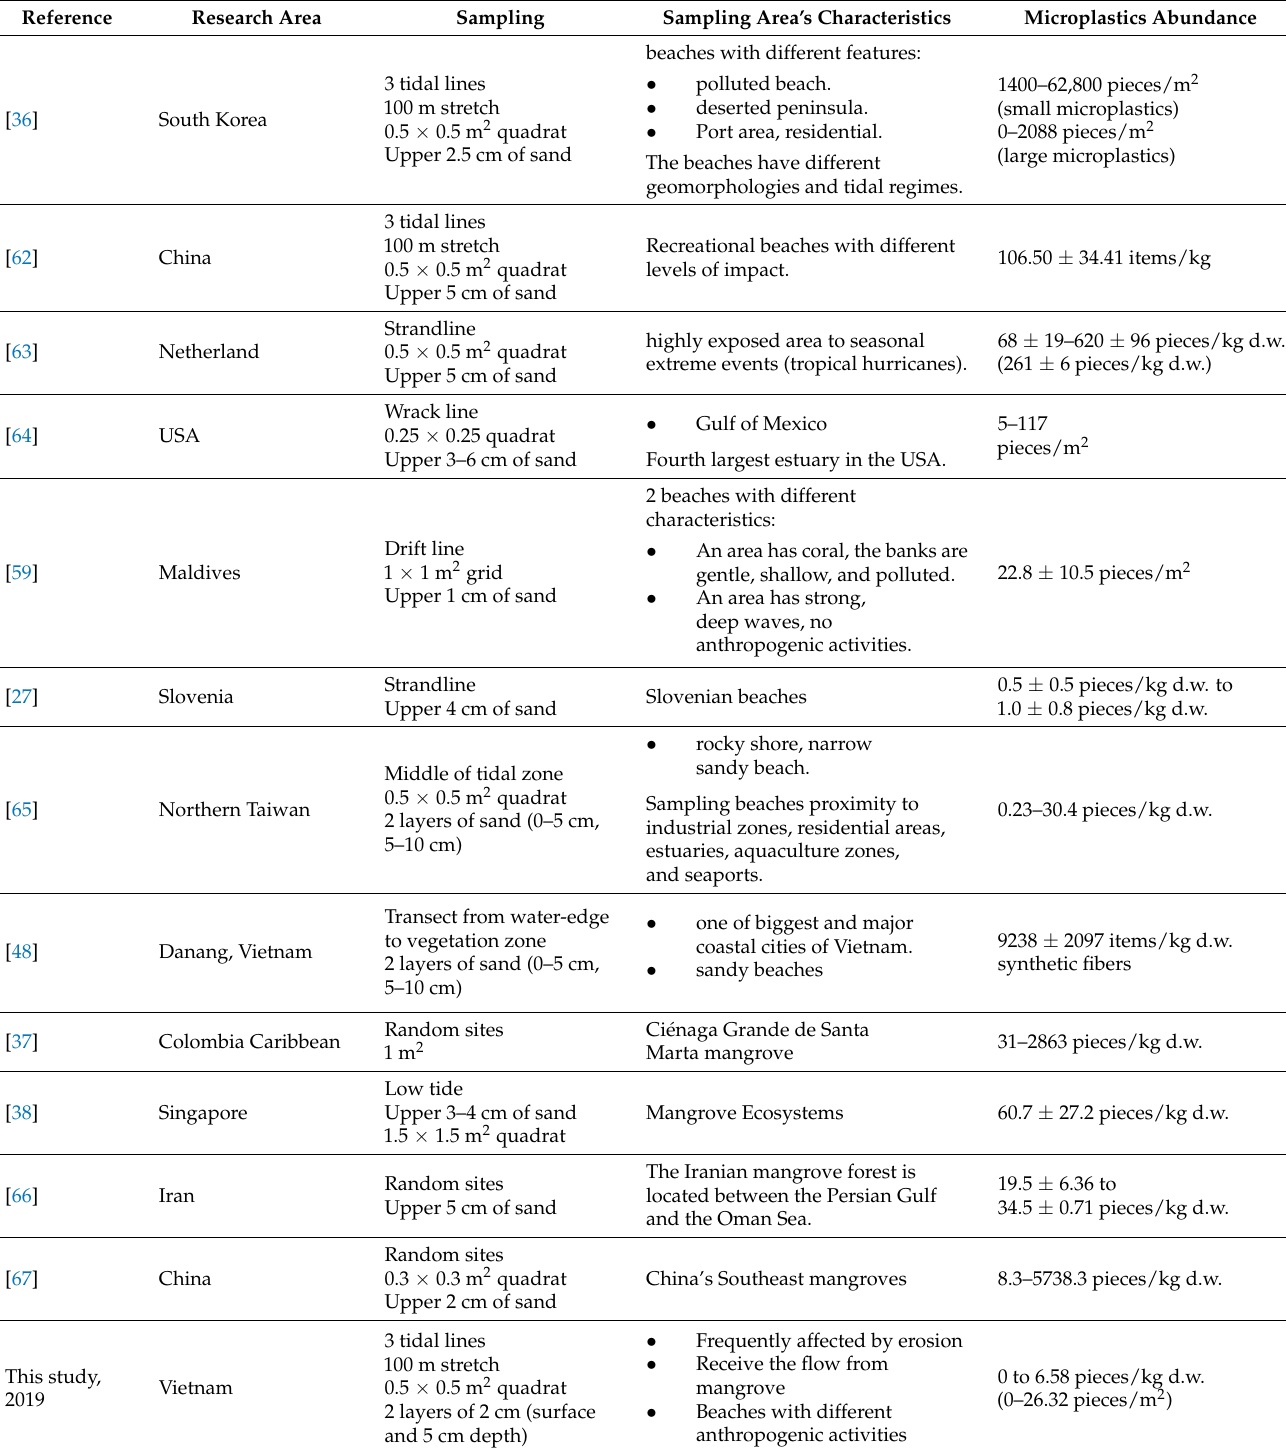
Table 3. Different researches in beach sand in the world in comparison with this